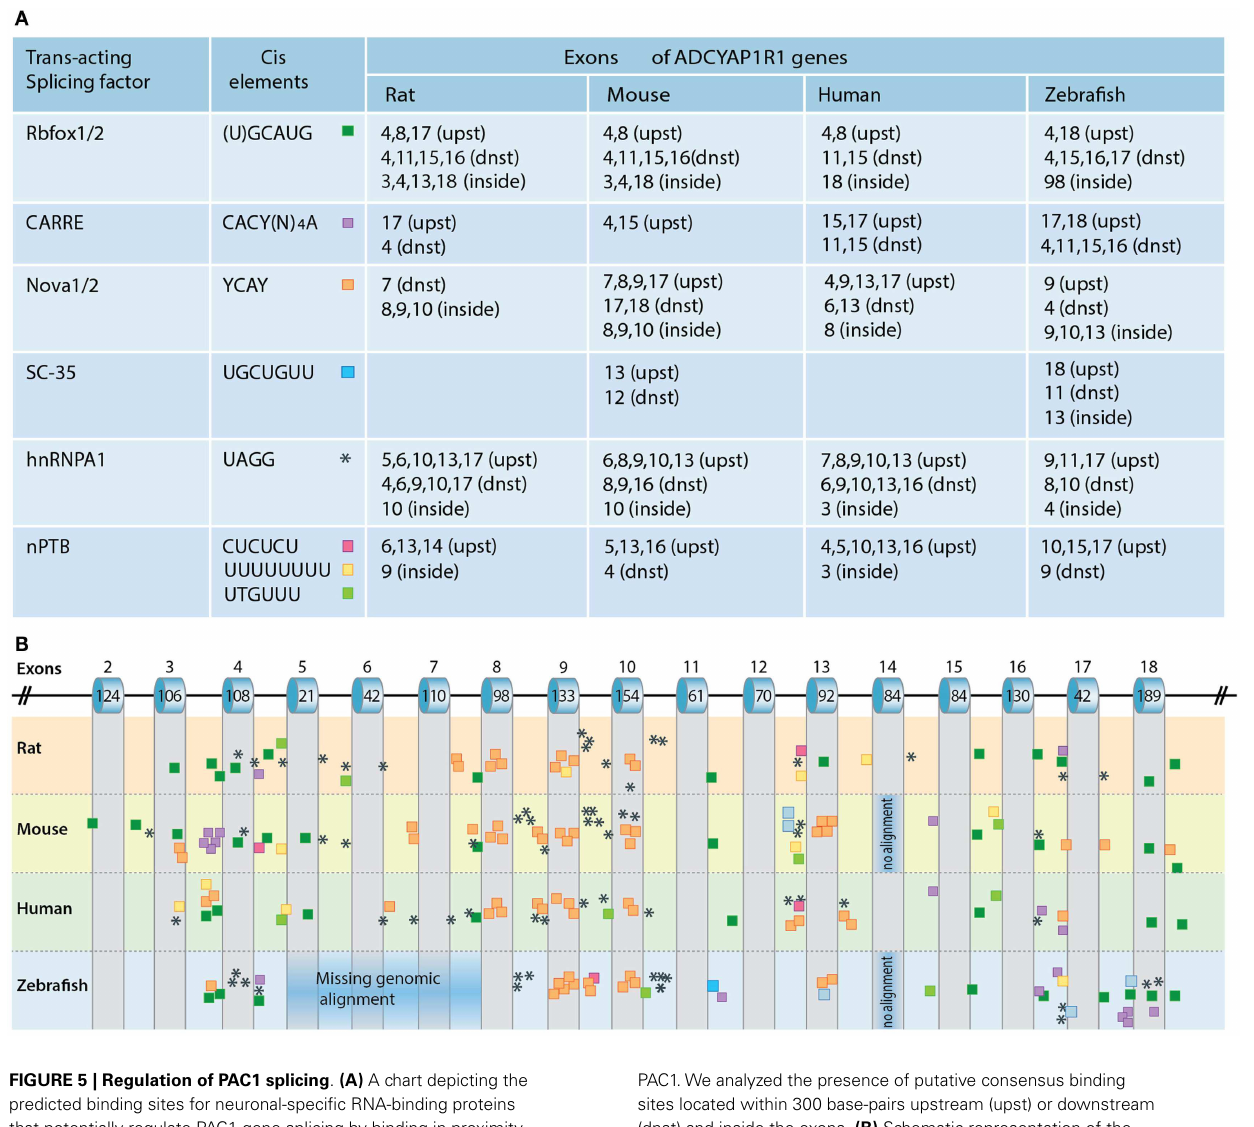
PAC1.We analyzed the presence of putative consensus binding sites located within 300 base-pairs upstream (upst) or downstream (dnst) and inside the exons. (B) Schematic representation of the PAC1 gene in which the location of the analyzed cis-acting elements is color-coded as above. Corresponding exons numbers and sizes (bp) are